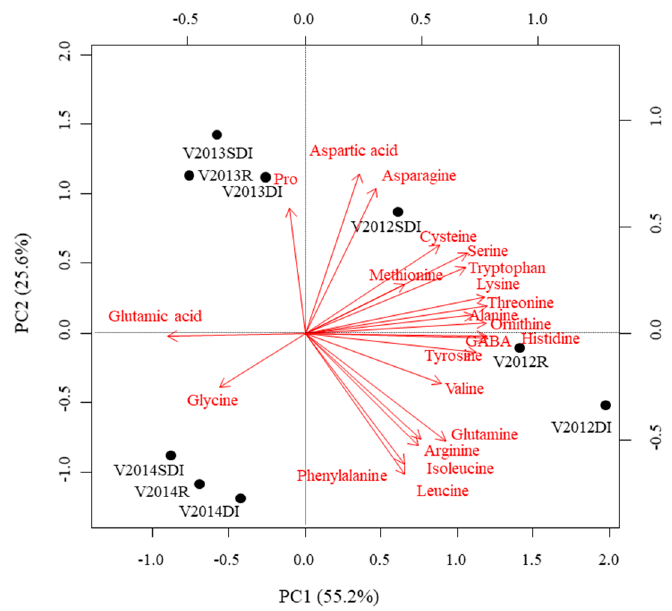
Figure 1. Principal component analysis (PCA) of Godello musts: Biplot for the first two principal components (PC) for the concentrations of free amino acids in musts. R = Rain-fed, DI = Drip irrigation, SDI = Subsurface drip irrigation.